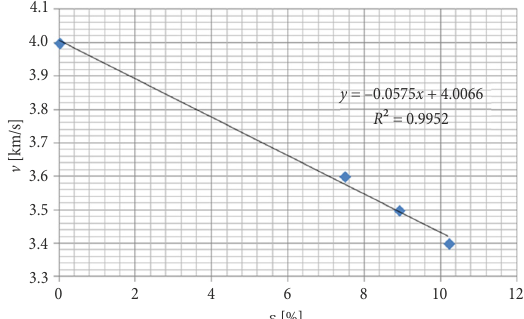
Fig. 9. Dependence of signal velocity of steel 04Kh18N10 emitted by the sensor-imitator on the degree of plastic deformation under the implementation of the DNP